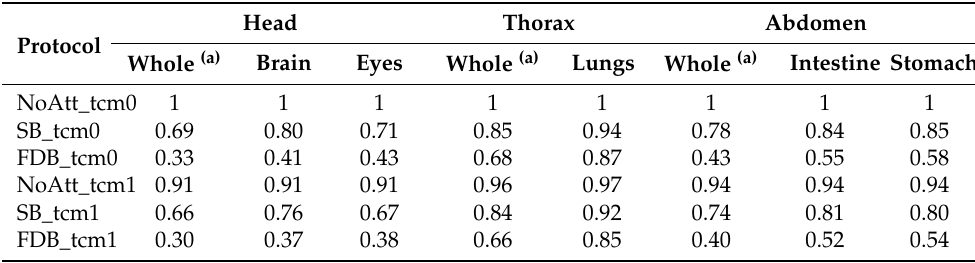
Table 5. The relative dose absorbed in the head, thorax and abdomen using different scanning protocols.